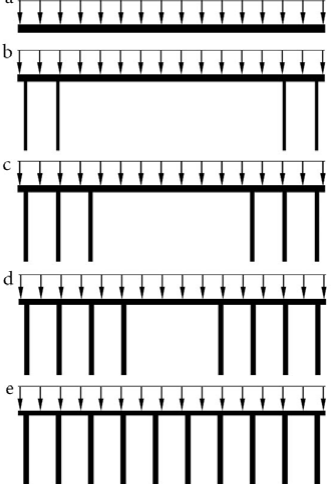
fig. 2. Distribution variants of the raft piles under the